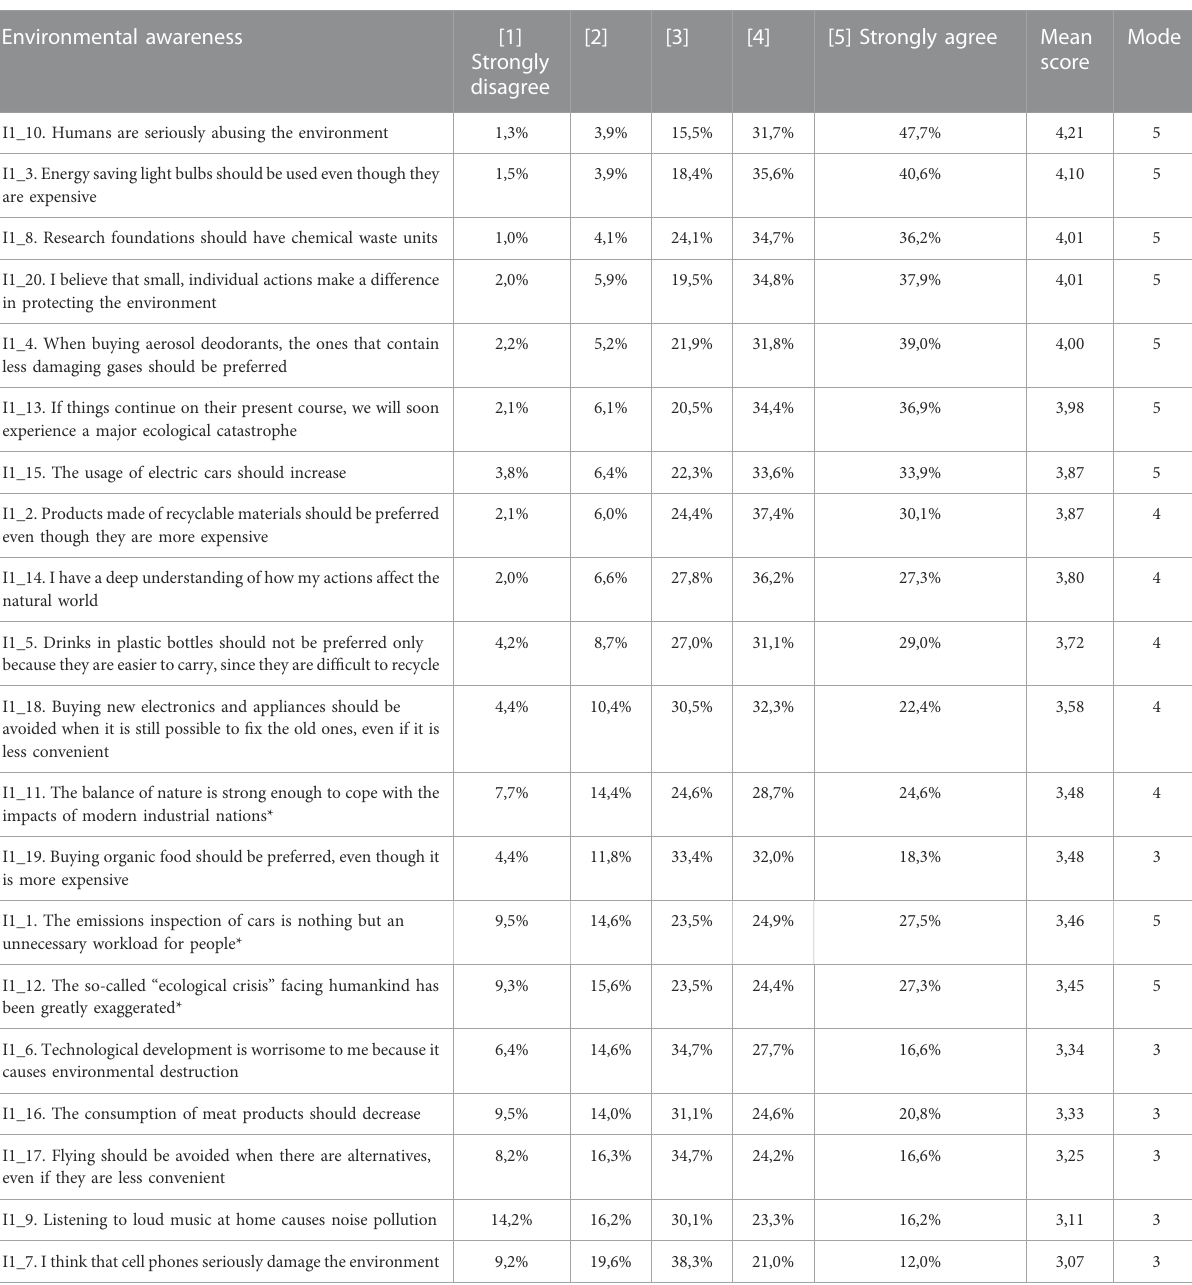
TABLE 3 Environmental awareness Environmental